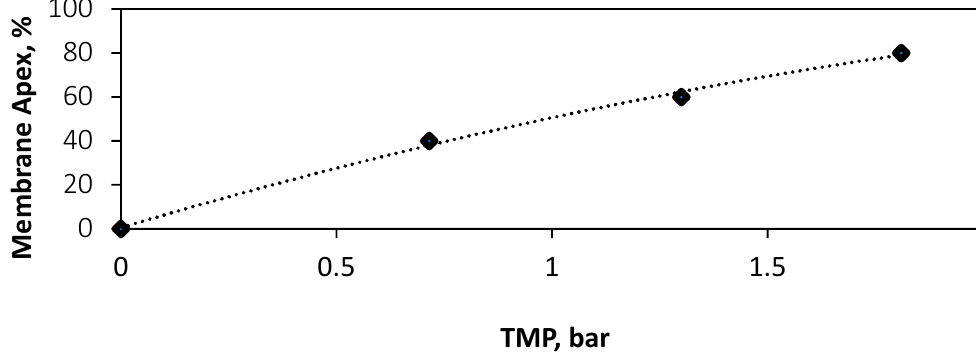
Figure 3. Relationship between the TMP applied in the FO system and expected apex point of the membrane as a percentage of channel height.